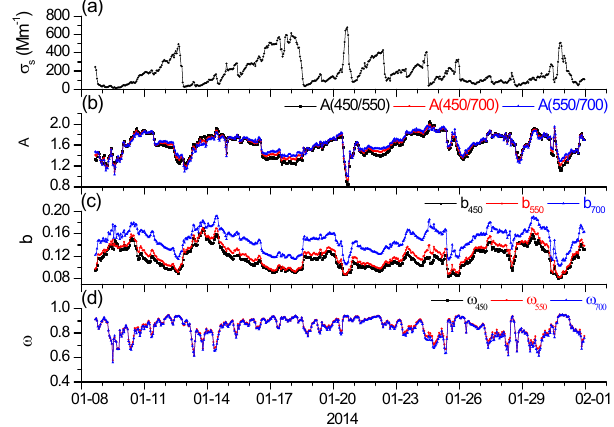
Figure 3. Temporal variations in (a) hourly average σ s , 550 , (b) the Ångström exponent of σ s ( Å ), (c) the backscattering fraction ( b) , and single scattering albedo ( ω) at 450, 550, and 700nm. Å (450 / 550) represents the Ångström exponent calculated from σ s at 450 and